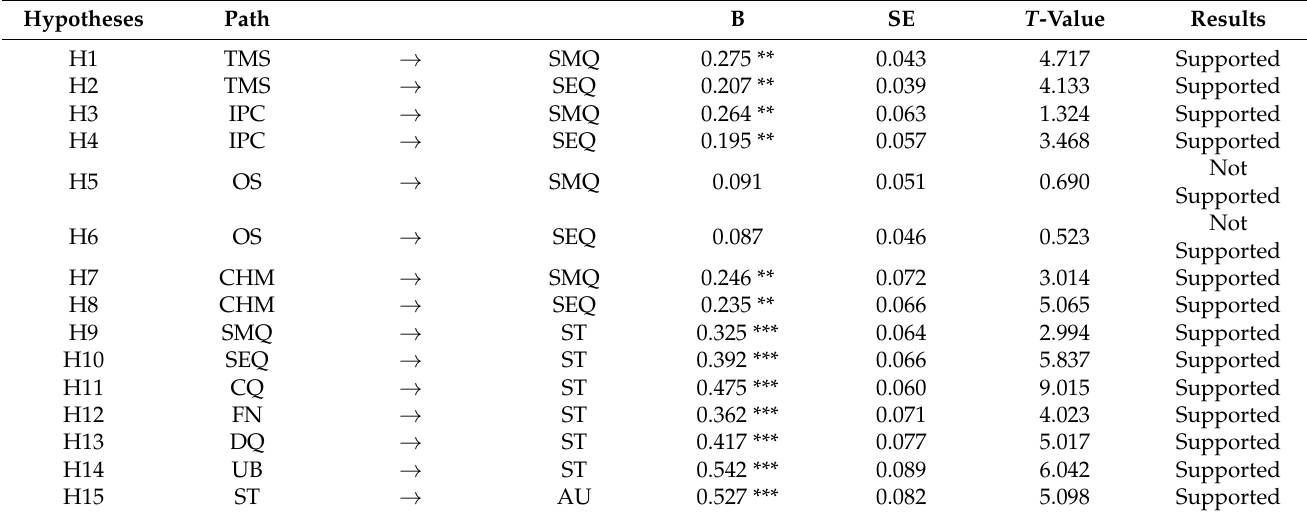
Table 6. Structural model analysis.